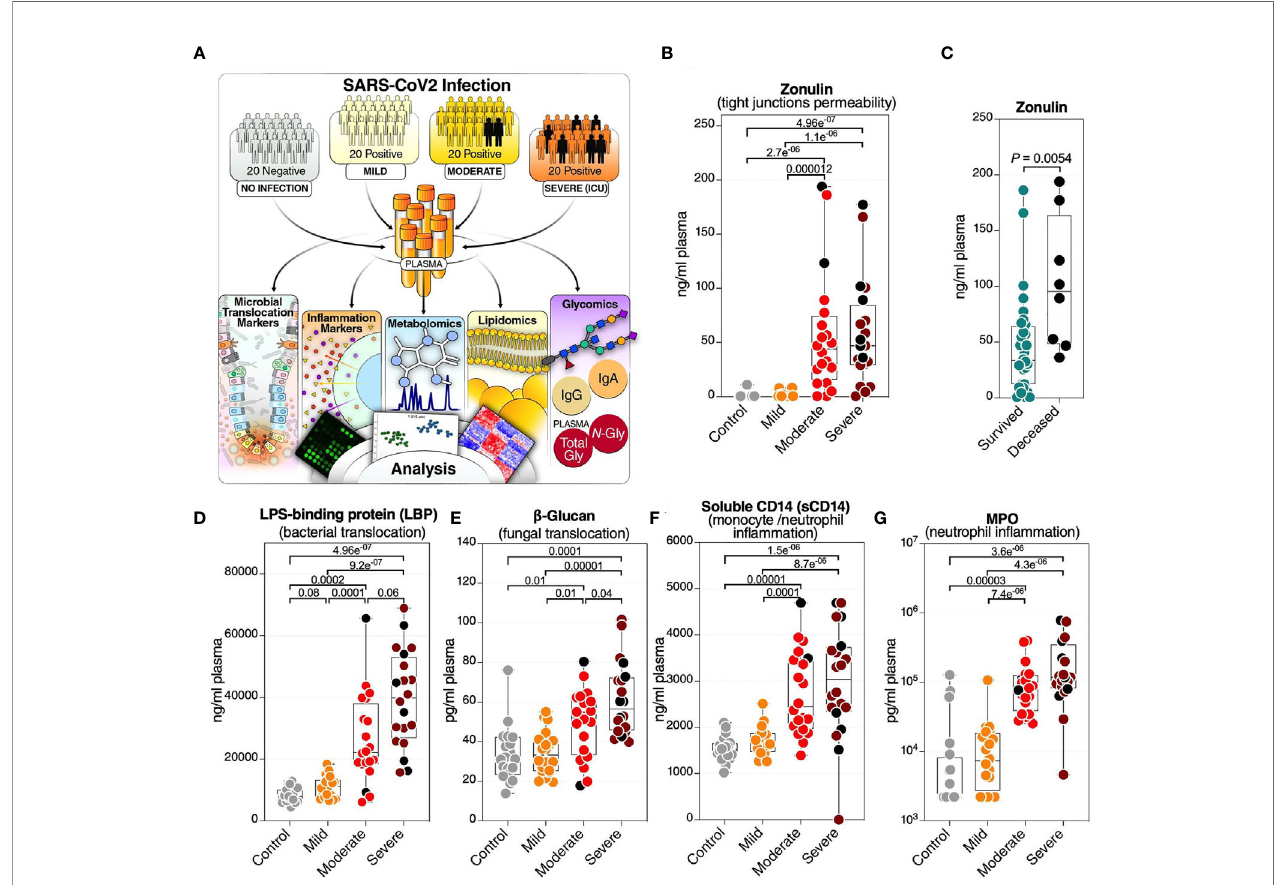
FIGURE 1 | Severe COVID-19 is associated with an increase in markers of tight junction permeability and microbial translocation. (A) An overview of the main cohort study design; moderate and severe patients were hospitalized; severe indicates patients in the intensive care unit. (B) Levels of plasma zonulin, are higher during moderate and severe COVID-19 compared to mild COVID-19 or controls. Kruskal – Wallis test was used for statistical analysis. False discovery rate (FDR) was calculated using the Benjamini-Hochberg method. Symbols in black indicate deceased. (C) Zonulin levels are higher in hospitalized COVID patients (n=40) who eventually died from COVID-19 (n=8) compared to survivors (n=32). Nominal P -value was calculated using the Mann – Whitney U test. (D – G) Levels of LBP (D) , b -Glucan (E) , sCD14 (F) , and MPO (G) , are higher during severe COVID-19 compared to mild COVID-19 or controls. Kruskal – Wallis test was used for statistical analysis. FDR was calculated using Benjamini-Hochberg method. Black dots indicate